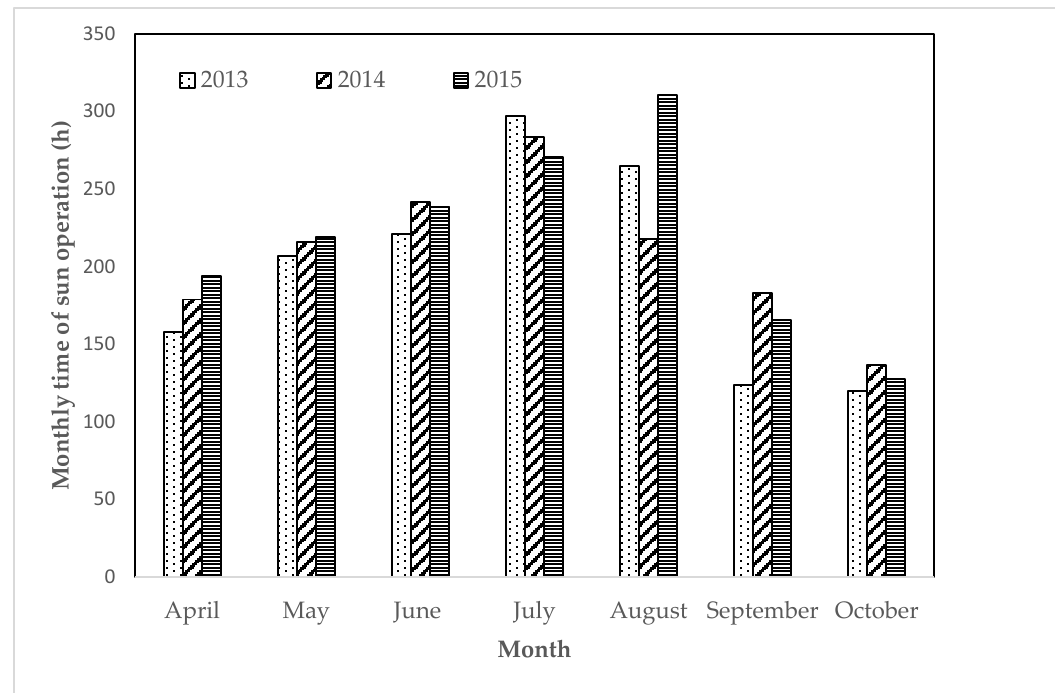
Figure 3. Sum of monthly hours of solar radiation period in sugar beet growing season in the period of studies.